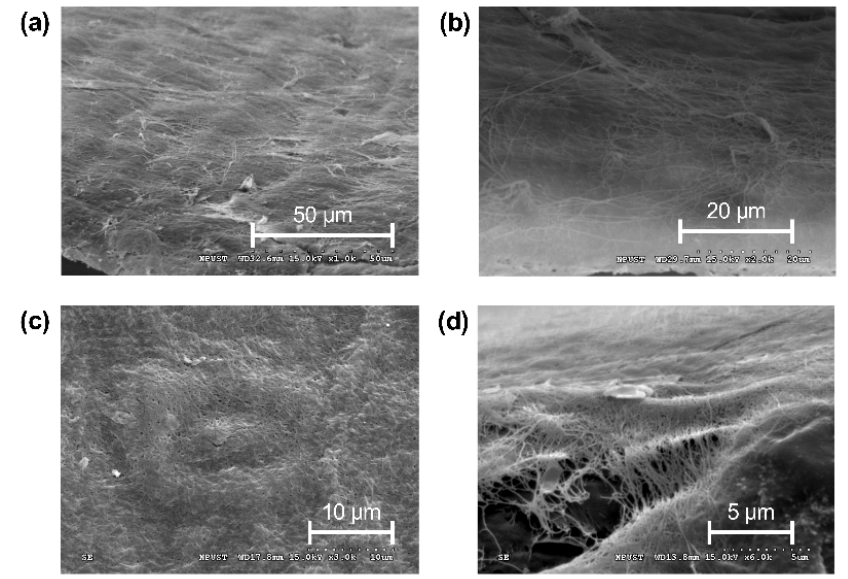
Figure 9. Surface SEM images of dry bacterial cellulose produced by K. intermedius . The magnification for images ( a ), ( b ), ( c ), and ( d ) was 1000 × , 2000 × , 3000 × , and 6000 × , respectively.